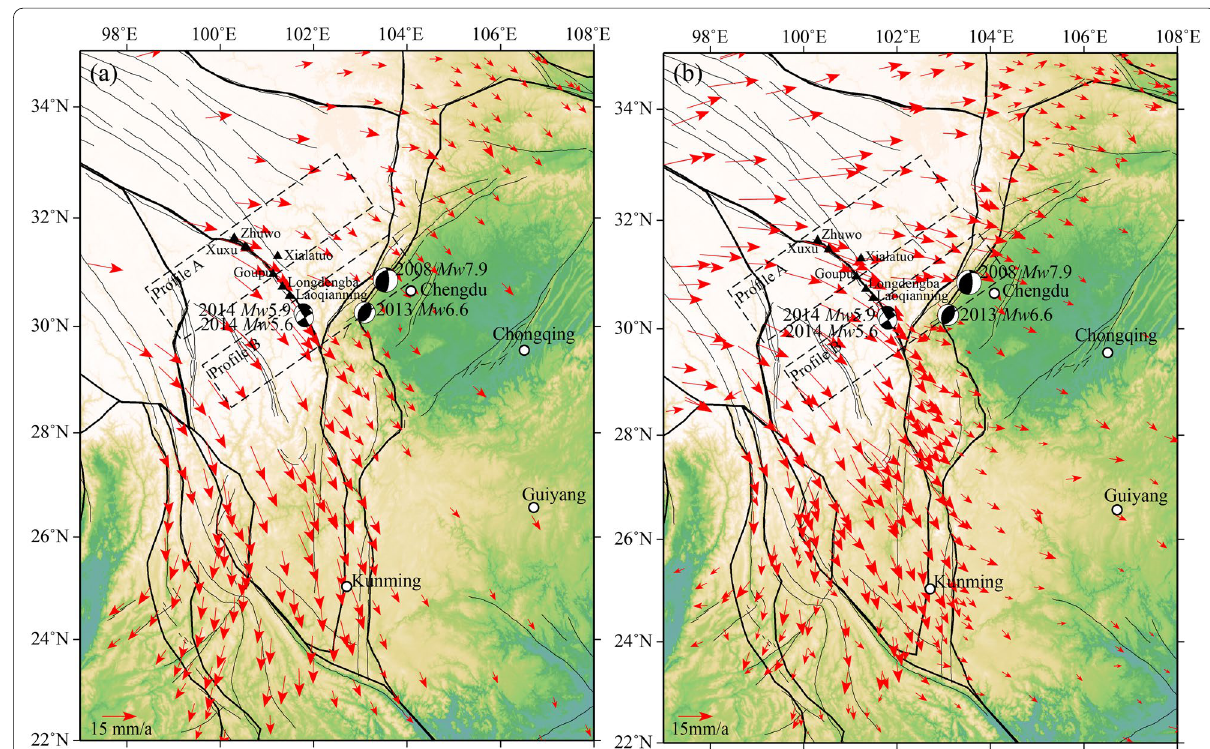
Fig. 3 GNSS velocity fields and profiles across the Xianshuihe Fault Zone. a and b The 1999–2007 and 2016–2020 GNSS velocities relative to the stable Eurasian Plate. The black triangles represent the fault-crossing observation sites. The black polygons denote the profiles plotted in Fig.